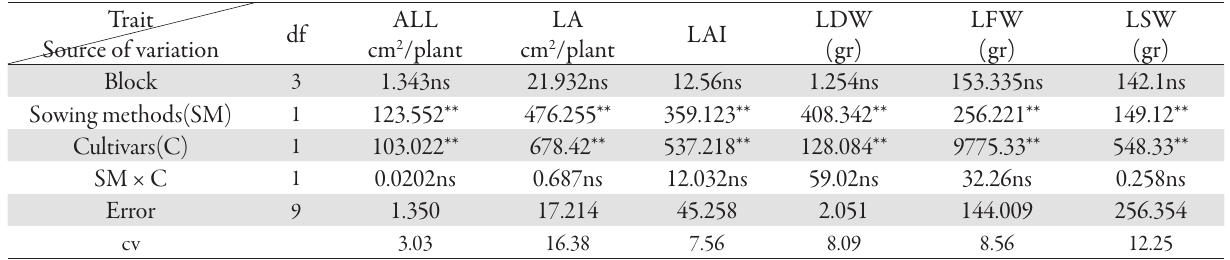
Tab. 6. Analysis of variance effect of sowing methods and cultivars on length of the aerial leaves, leaf area, leaf area index, saturation/dry/fresh weight